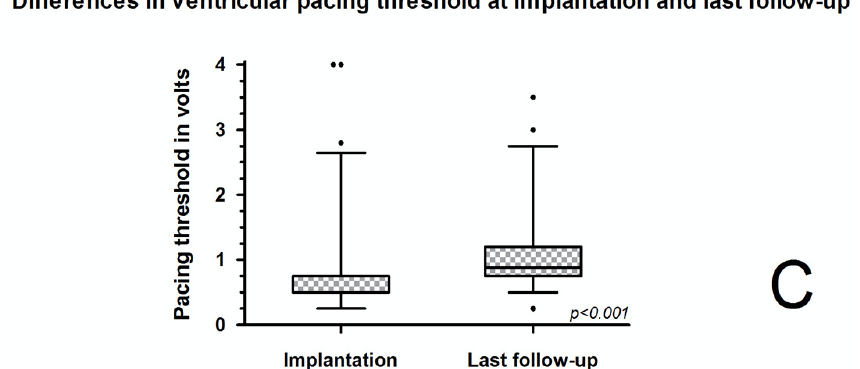
Figure 1. Device characteristics (lead impedance, sensing and pacing threshold) at implantation and at last follow-up: ( A ) differences in ventricular lead impedance at implantation and at last follow-up; ( B ) differences in ventricular sensing at implantation and at last follow-up; ( C ) differences in ventricular pacing threshold at implantation and at last follow-up. Whiskers in box plots mark the 95% (2.5–97.5%) confidence interval.